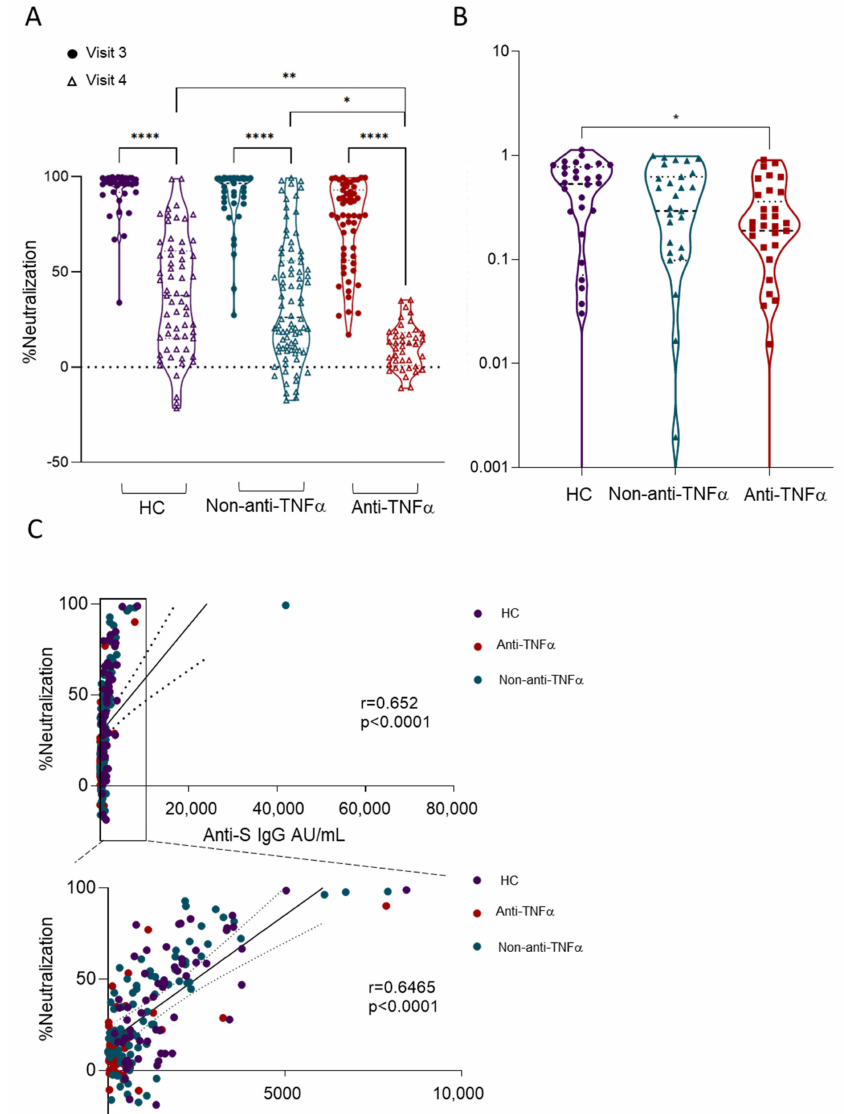
three VOCs (Figure 6C), compared to the HC and non-anti-TNF α groups ( p < 0.0001 and p < 0.0008, respectively).